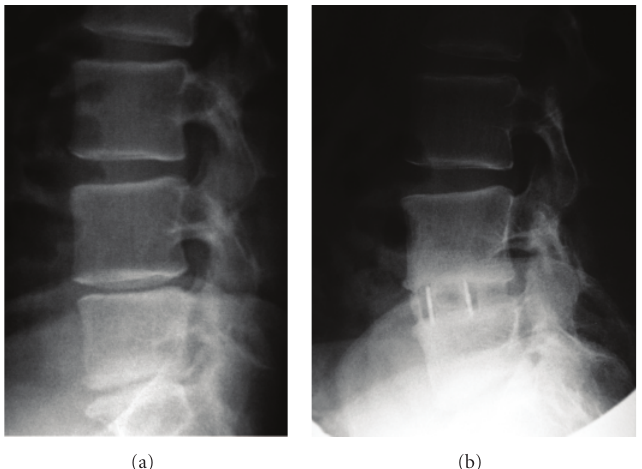
Figure 3: Case example number 2. Male, 58 years old, long history of lumbar axial pain and recurrent crisis event. VAS scores-preoperative 6; 1-week 3; 24-month 1. Patient underwent an L4L5 stand-alone lateral interbody fusion using rh-BMP. (a) Preoperative lateral orthostatic X-ray (b) 12-month lateral orthostatic